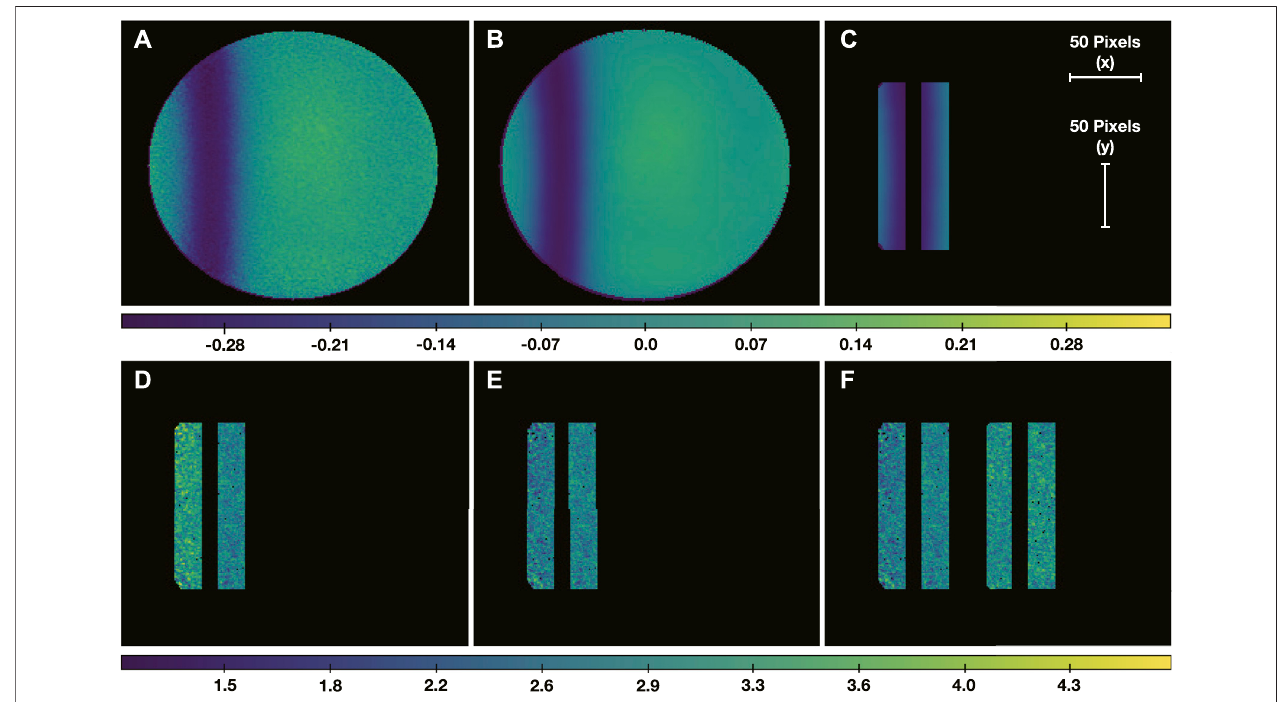
FIGURE6|(A) : asingle Dopplergram,asseenin Figure 2C . (B) : anaverageDopplergram,created bymedian-combiningall framesthroughout thenight. (C) : the average Dopplergram, restricted to only the indices which are used in fi nal calculation — the insensitive top, bottom, and central zones have been excluded, as well as all the disk outside thelinear regime ofthe absorption linepro fi le. (D) : a single “ residual image, ” created by subtracting the average Dopplergram (Panel (C) ) from the single Dopplergram (Panel (A) ). (E) : The left half of the residual image has been multiplied by a value of − 1, to account for the change in sign when crossing the bottom of the absorption line. (F) : the same steps are applied to a region opposite the center of the disk, in a region suf fi ciently outside the velocity-sensitive regime, to generate a “ continuum residual ” via the exact same process to characterize instrumental noise and effects. This panel shows the continuum residual plotted to the right of the velocityresidual.Eachrowofpanelsmaintainsthesamecolorscaling(correspondingtovaluesofDN,orDataNumbers),asshownintherespectivecolorbarbeloweach trio. Each panel maintains the same axis scaling in pixels, as indicated by the inset bars in (C)